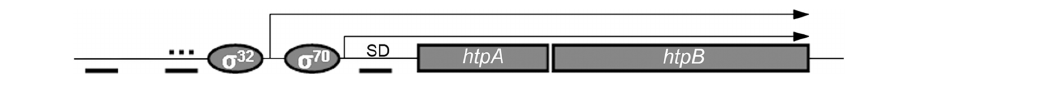
FIGURE 2 | Upstream regulatory region and gene organization of the L. pneumophila htpAB operon. Diagram (not at scale) showing the known regulatory elements in the promoter region and the putative bicistronic transcripts (thin, right angle arrows) produced from the σ 32 stress promoter